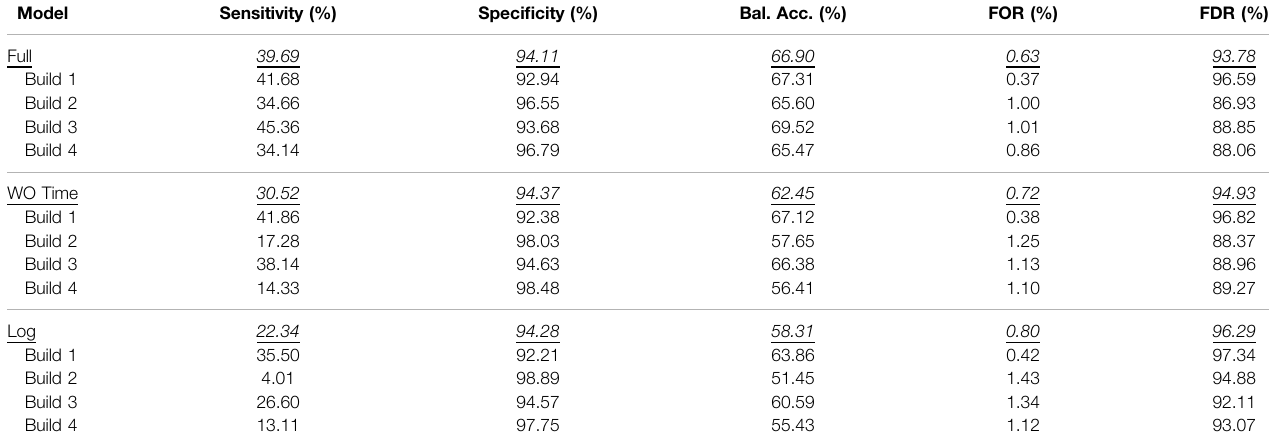
TABLE 6 | Model performances. The top lines for each input feature set represents the aggregated performance across all four models and respective builds.